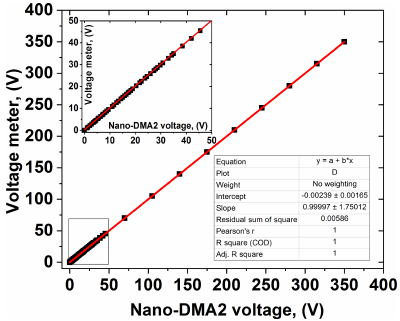
Figure 2. An example of voltage calibration of the